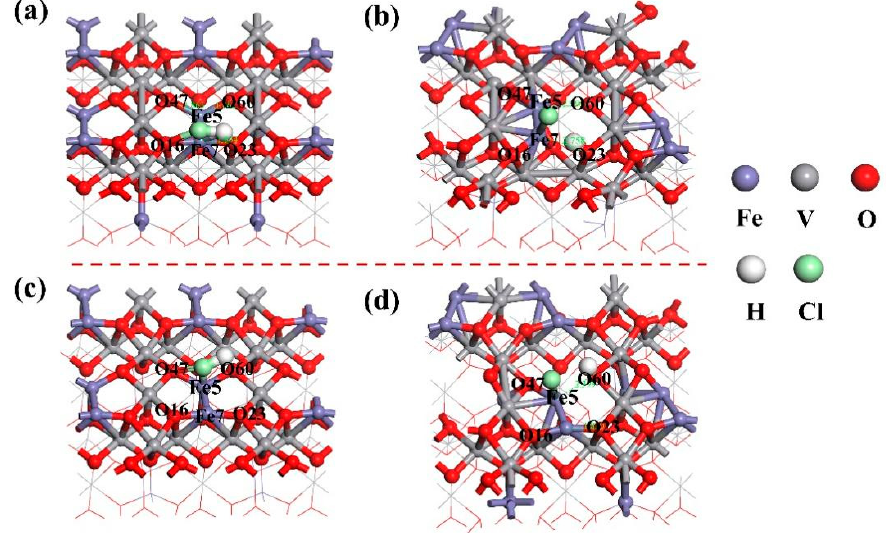
Figure 8. HCl adsorption on FeV 2 O 4 : ( a ) HCl adsorption on Fe7 site before optimization. ( b ) HCl adsorption on Fe7 site after optimization. ( c ) HCl adsorption on Fe5 site before optimization. ( d ) HCl adsorption on Fe5 site after optimization.